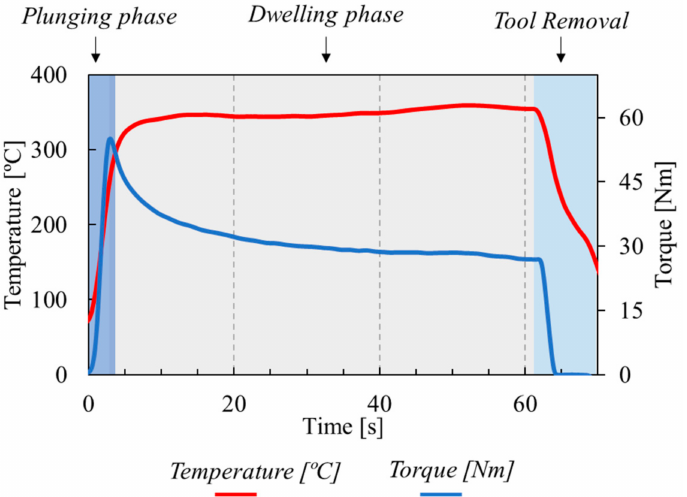
Figure 6. Evolution of temperature and torque with time for the weld produced in the AA7075 aluminium alloy, with a tool diameter of 16 mm and a rotational speed of 660